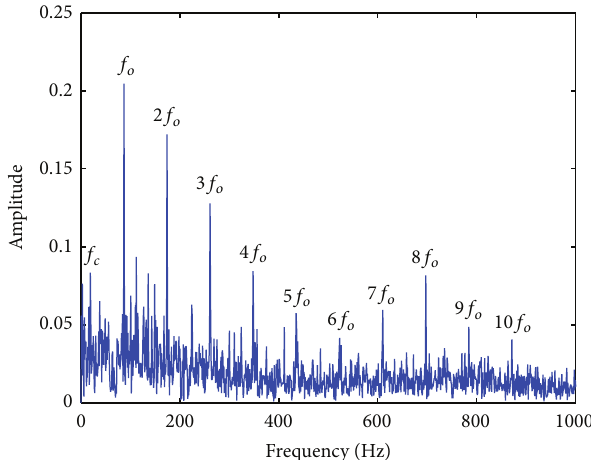
Figure 10: The envelope spectrum analysis of the eighth decom- posed component.